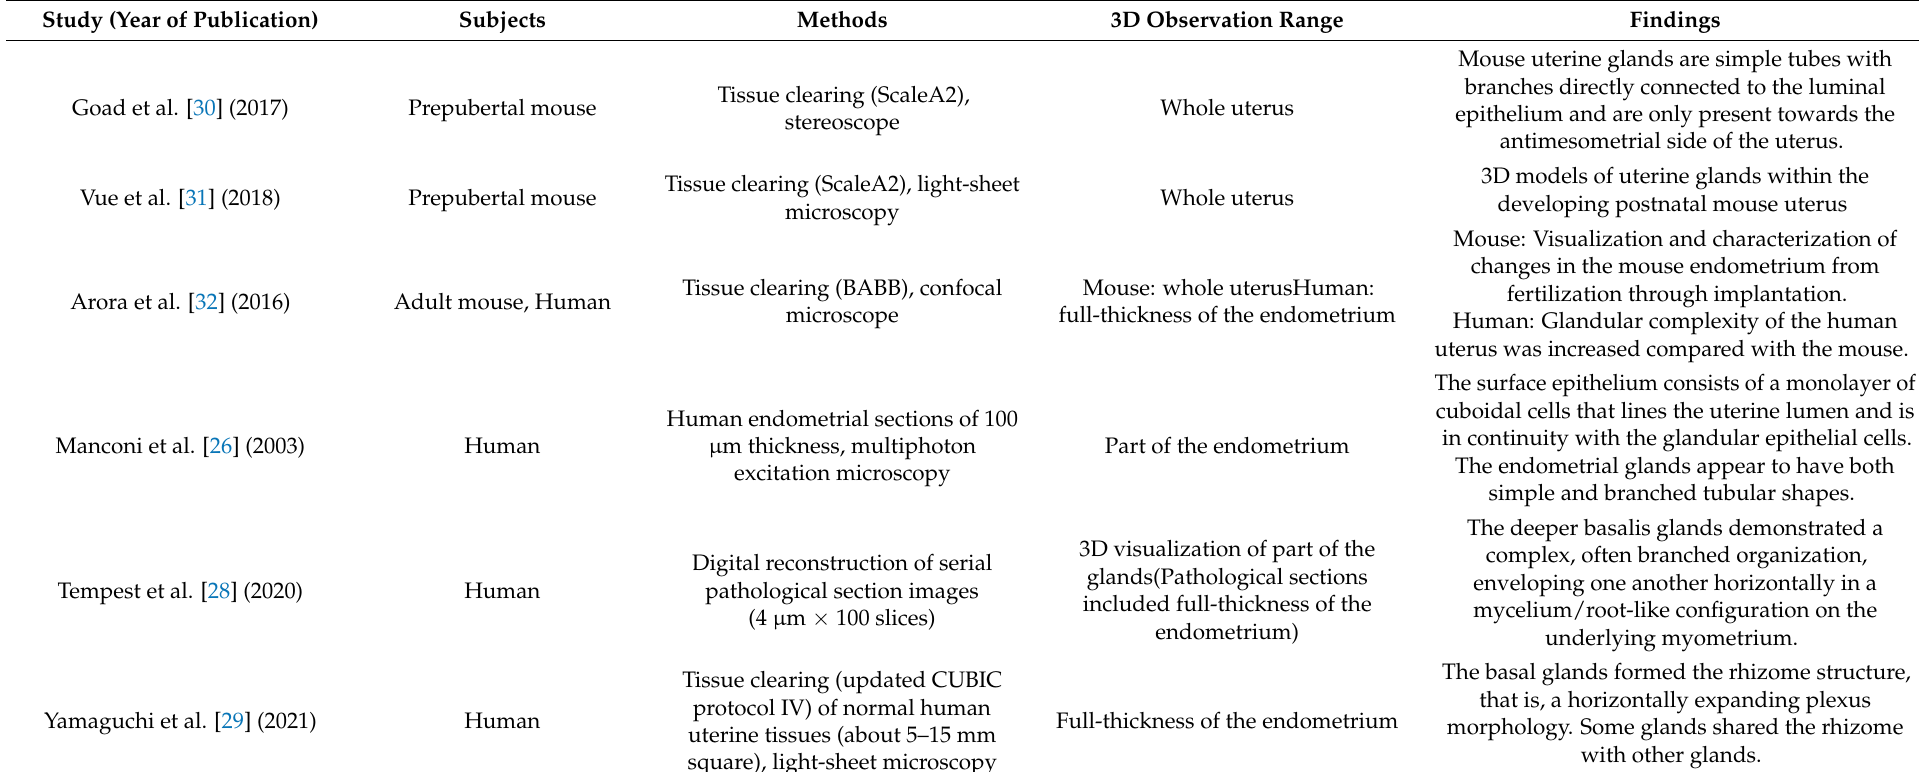
Table 1. The significant studies of the 3D structure of mouse and human